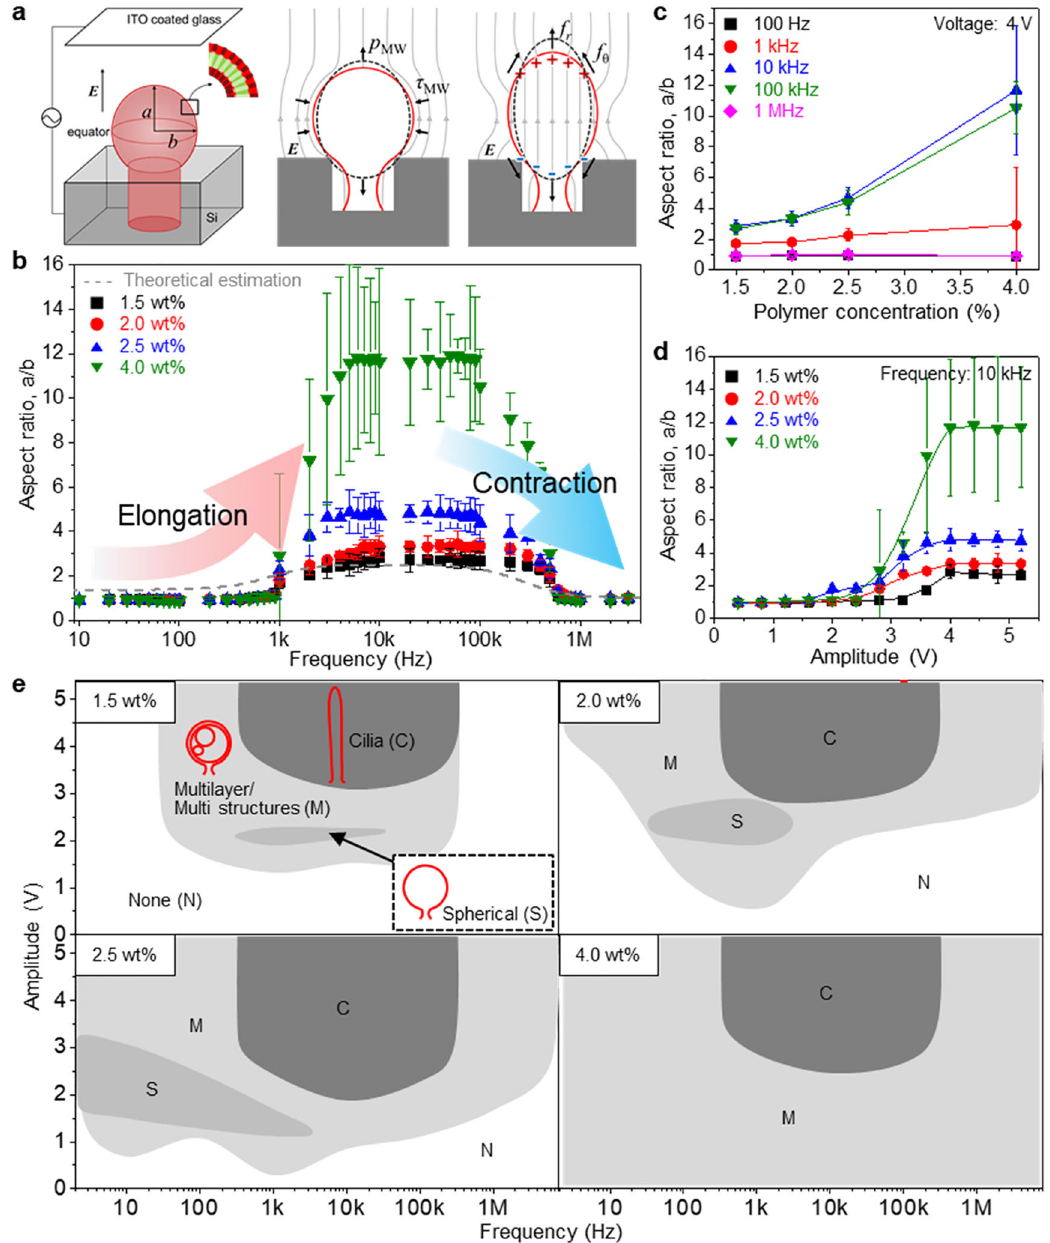
Fig. 3 Morphology dynamics of a 3DBCPM under an electric fi eld with different amplitudes and frequencies. a Mechanism for the morphological transformation of a 3DBCPM related to net charge distributions on the membrane of the 3DBCPM in an electric fi eld, where τ MW , p MW , f θ , and fr denote the radial Maxwell stress and pressure and the tangential and normal forces, respectively. b Theoretical modeling and experimental observation for the frequency-dependent morphology dynamics of 3DBCPM. All 3DBCPMs were produced for an identical time of an hour (except for the time to increase an amplitude by 100 mV every 5 min until the amplitude reached a desired value). Data are presented as means± standard deviation ( n = 5 independent samples). c , d Changes in the aspect ratio of the 3DBCPM as a function of c block copolymer concentrations and d electric fi eld amplitude. Data are presented as means± standard deviation ( n = 5 independent samples). e Morphological phase diagram of the 3DBCPM associated with three factors: block copolymer concentration and frequency and amplitude of the electric fi